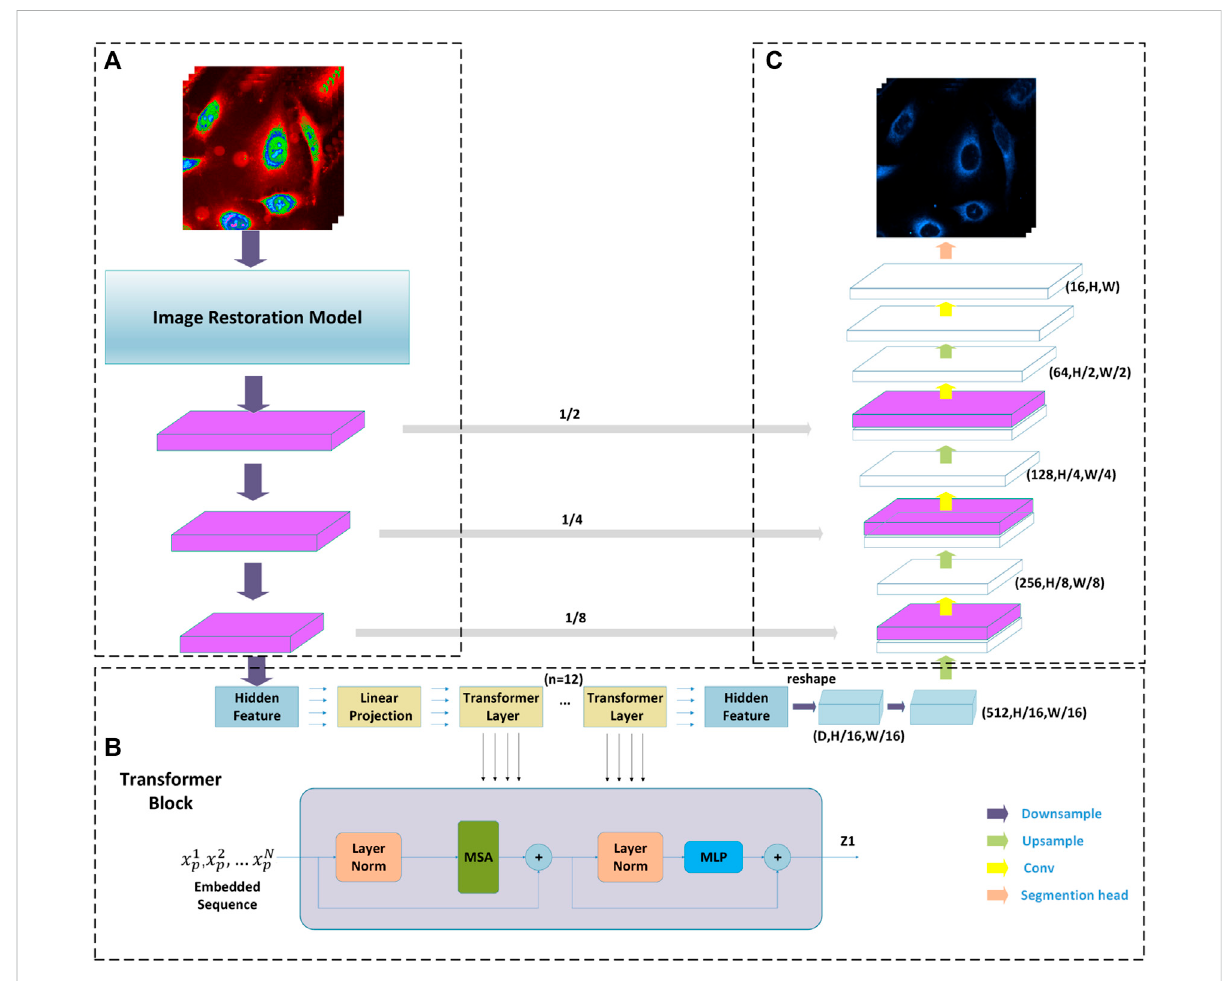
FIGURE 4 Diagram of the Transformation and CNN multimodel fusion-based network architecture underpinning presented tool. Part (A) is CNN blocks combined with an image restoration model; Part (B) is a transformer taking raw image as input; and part (C) is a classical Unet where the decoder takes the output of the transformer as its